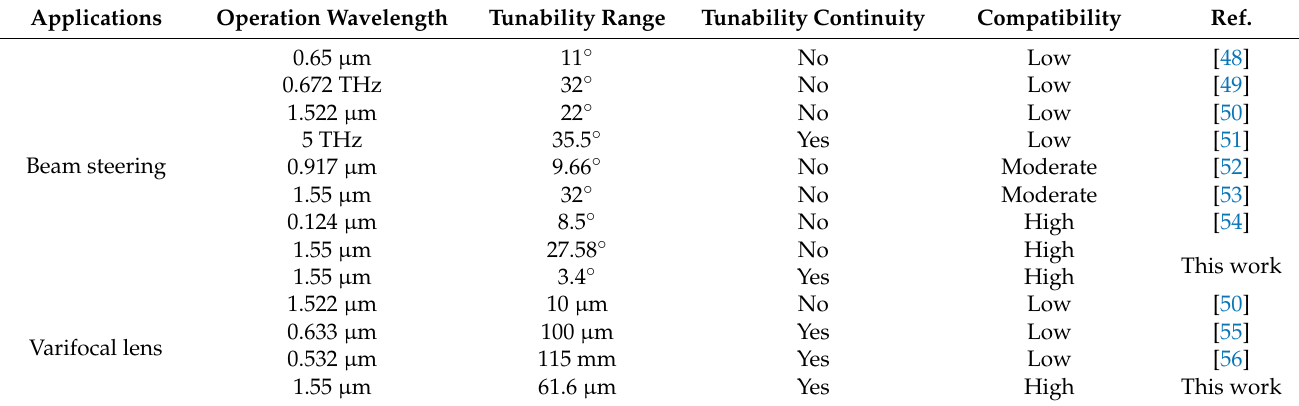
Table 1. Performance comparison among typical tunable